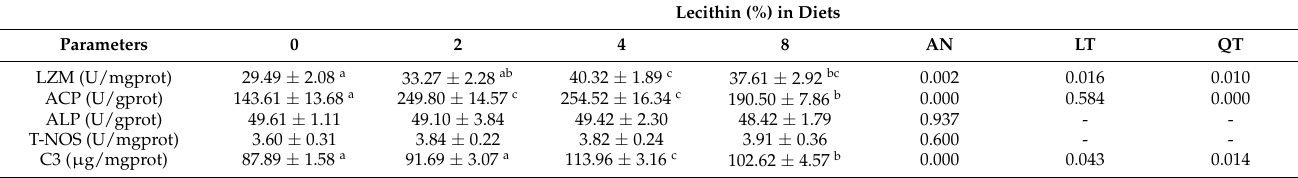
Table 6. Effects of dietary soybean lecithin on the immune parameters in the liver of largemouth